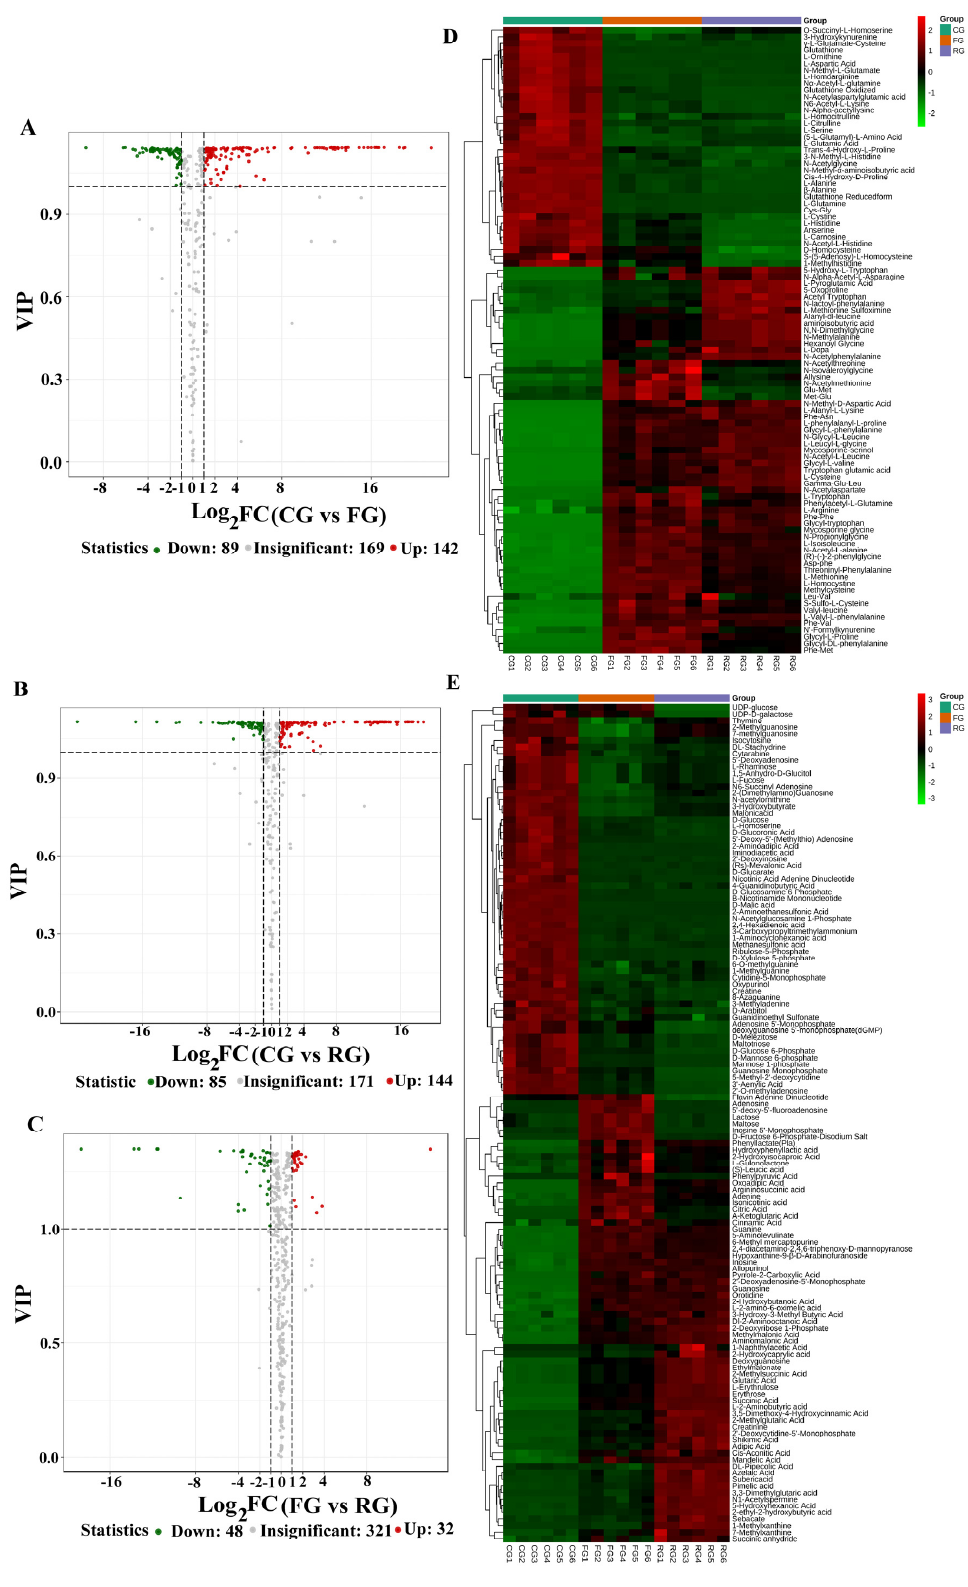
Figure 3. Volcano plots showing the distribution of all metabolites based on their fold-change values ( x -axis, on a logarithmic scale) and VIP scores (VIP > 1 and VIP < 1). A comparison is made